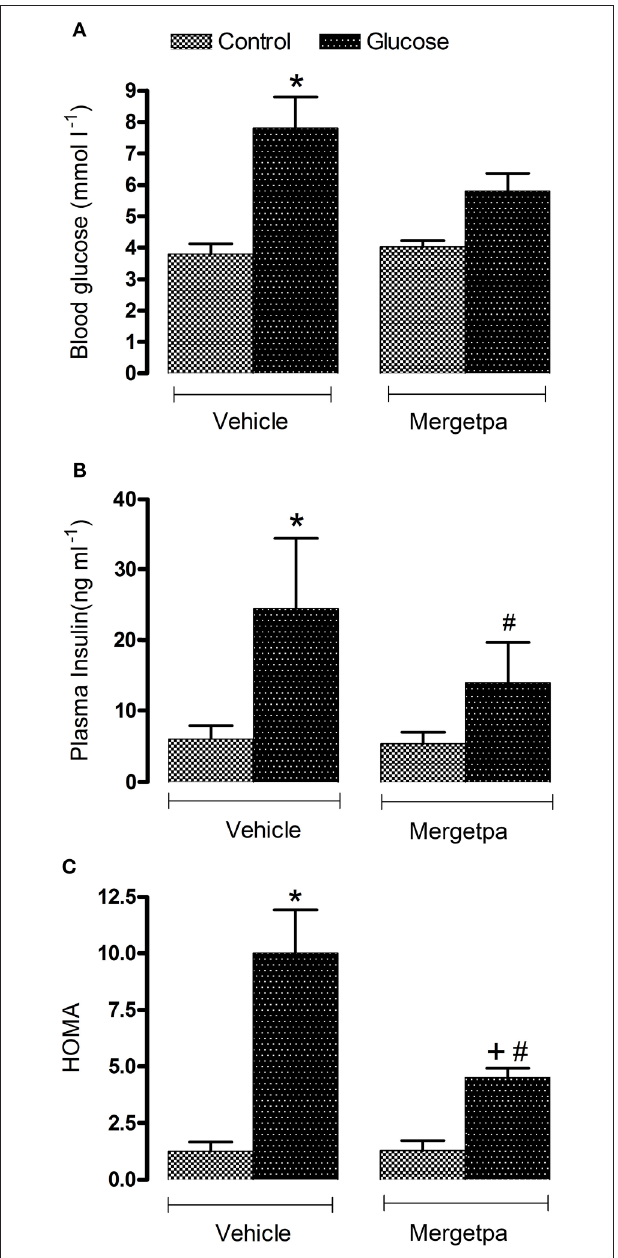
FIGURE 1 | Treatment effect on metabolic parameters. Effect of s.c. administered Mergetpa (1 mg.kg − 1 twice daily) for 7 days on (A) blood glucose, (B) plasma insulin and (C) insulin resistance assessed by the HOMA index. Data are mean ± SEM obtained from six rats per group. * P < 0.05 compared with control + vehicle; + P < 0.05 compared with glucose + vehicle; # P < 0.05 compared with control + Mergetpa. Data in vehicle treated rats are from a previous study (Haddad and Couture, 2016) but performed simultaneously.